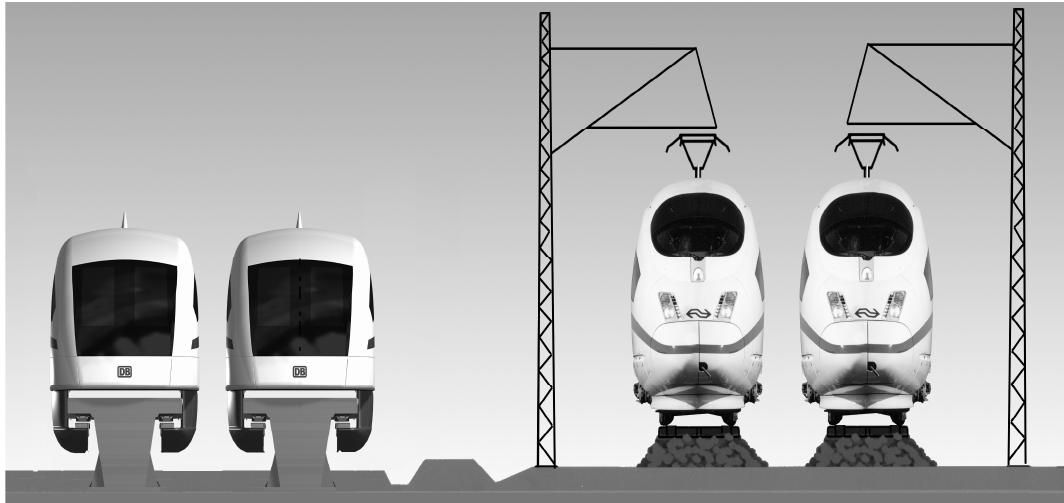
Fig 3. Transrapid and InterCityExpress